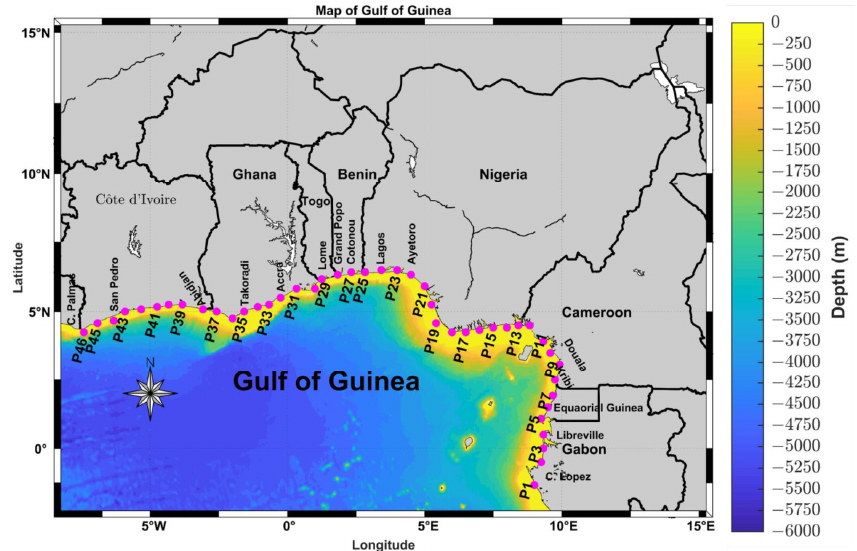
Figure 1. Map of the Gulf of Guinea arm of the Atlantic Ocean with the selected points P1-P46. Blue = deep ocean, yellow = coastal water/continental shelf.